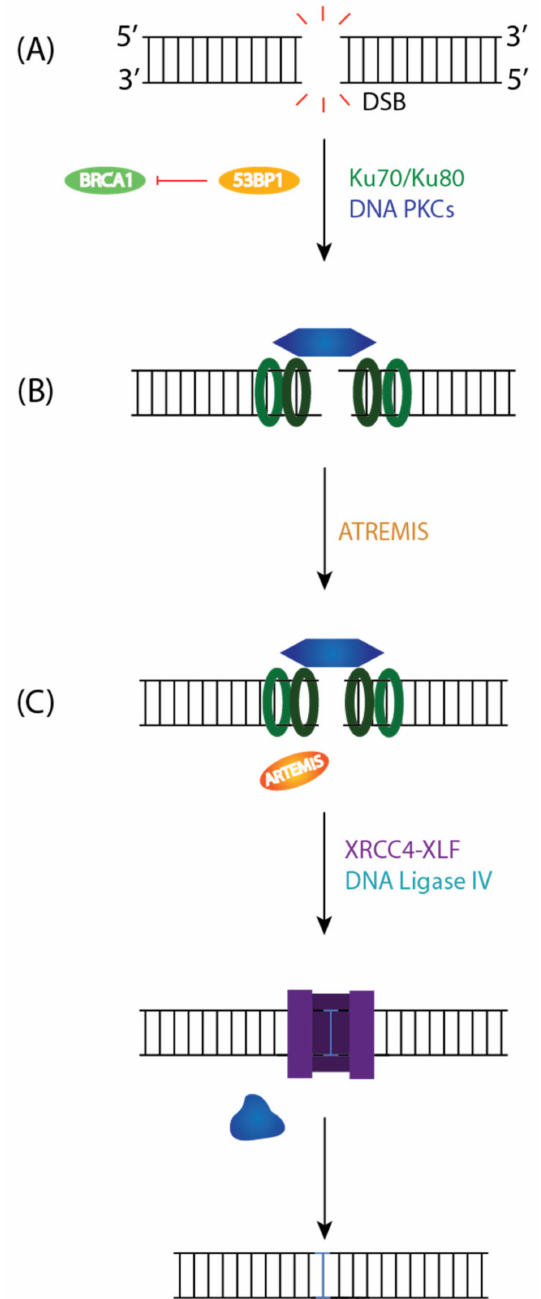
Figure 5. Canonical Non-Homologous End Joining (c-NHEJ) Pathway to Repair DSBs. ( A ) 53BP1 directs the repair pathway to NHEJ by inhibiting BRCA1 and end resection. The Ku80/Ku70 heterodimer binds to the DNA ends, aligns them, and recruits DNA PKcs to the DSB to activate its kinase domain. ( B ) DNA PKcs is autophosphorylated and will activate ARTEMIS resulting in limited resection. ( C ) The Ligase Complex, DNA Lig IV, and XRCC4 will stabilize the positioning of the ends before restoring the